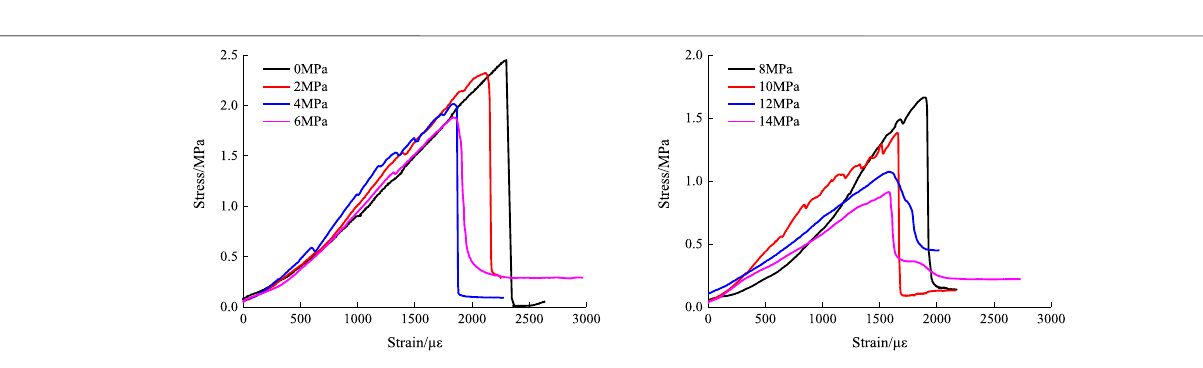
FIGURE 8 | The principal compressive stress-strain curve of SCC under biaxial tension-compression.